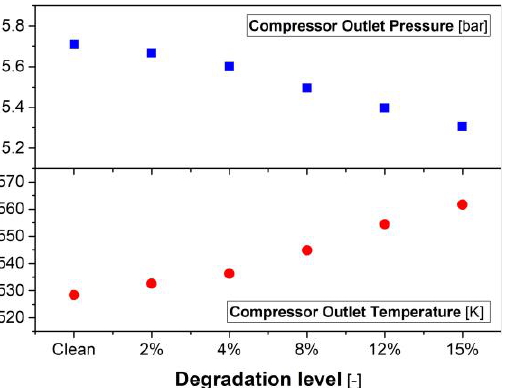
Figure 9. Compressor pressure ( top ) and outlet compressor temperature ( bottom ) for damaged compressor.